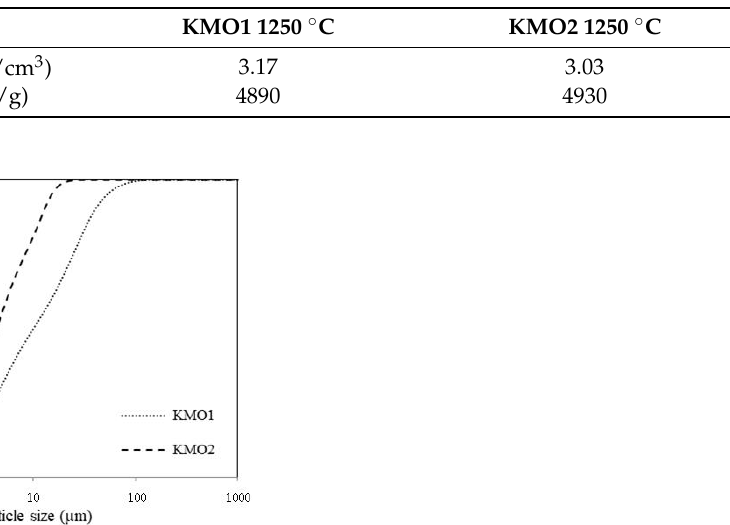
Table 4. Specific density and Blaine specific surface area (SSA) of the belite-sulfoaluminate (BCSA) cements from raw mixtures KMO1 and KMO2 sintered at 1250 °C (Blaine method, ToniPERM Standard Model 6578, ToniTechnic by Zwick, Ulm, Germany).